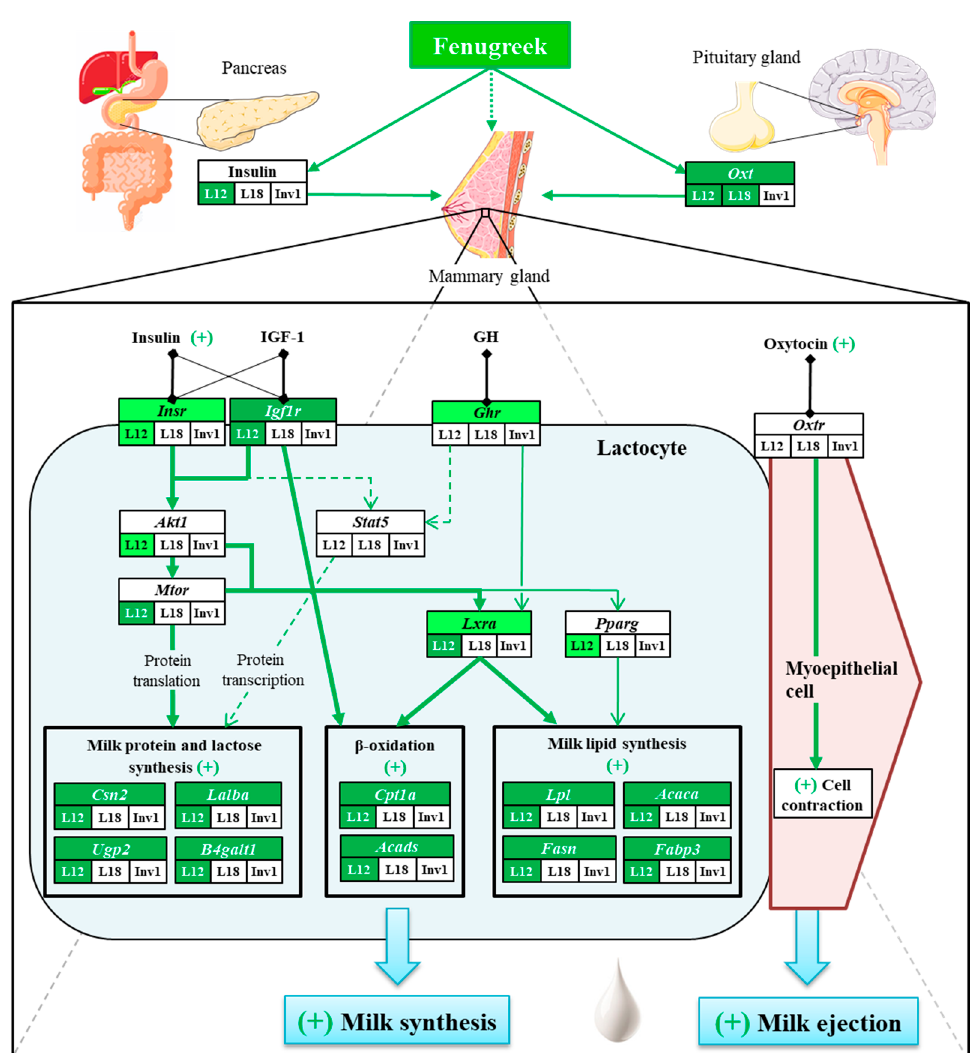
Figure 5. Suggested mechanisms of action of fenugreek on milk synthesis and secretion. Green arrows denote positive activation, bold and thin arrows represent main and secondary fenugreek action pathways, respectively. Dotted lines represent hypothetical pathway of action. Dark and light green boxes represent significant or trend increase respectively of gene expression or plasma concentration overall for upper box and at each lactation period for lower boxes. White boxes depict the lack of modulation by